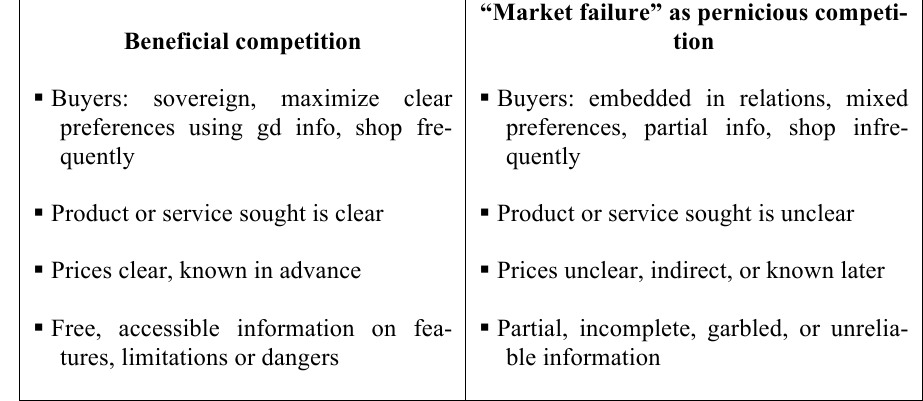
Structural and organizational conditions for beneficial and pernicious competition Beneficial